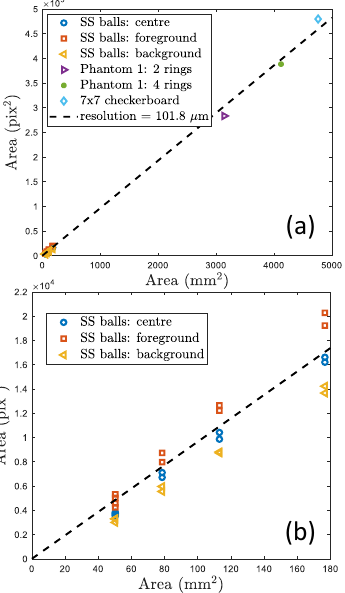
Fig. 5. (a) Calibration of pixel resolution and (b) the effects of parallax errors on the observed particle silhouette area. The error in an object’s silhouette area is liable to increase further as a result of the uncertainty in its depth location within the test